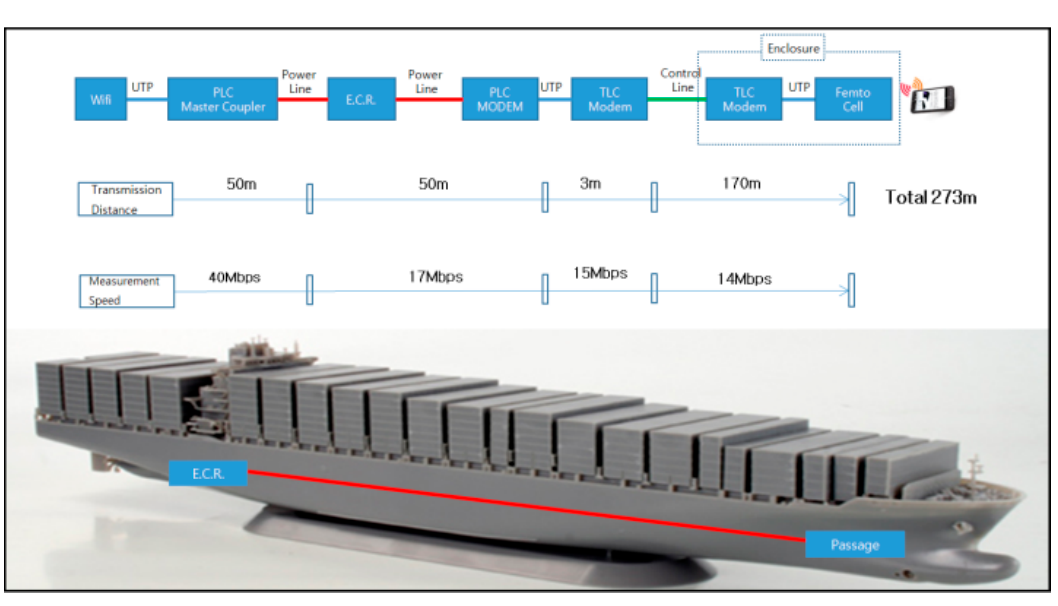
Figure 17 . Voice quality test using PLC-based TCP/IP communication. Figure 17. Voice quality test using PLC-based TCP/IP